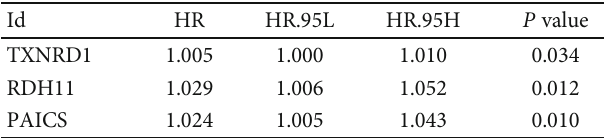
Table 1: Prognostic related metabolic genes, HR > 1 is a high-risk gene, and HR < 1 is a low-risk gene.